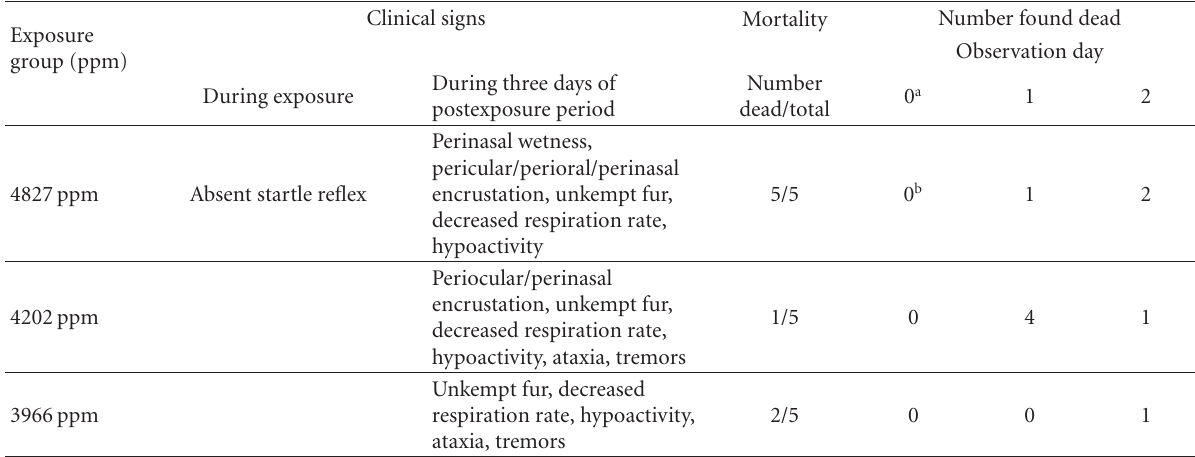
Table 4: Clinical observations, mortality rates, and day of death for female rats following 1-hour exposure to EO. Exposure group